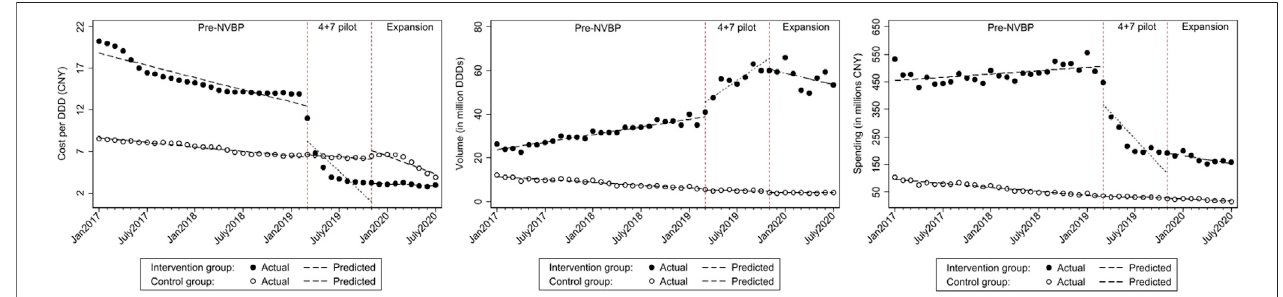
FIGURE2| Theobservedandpredicted (A) costperDDD (B) procurementvolume (C) procurementspendingfromsecondaryITSanalysiswithacontrolgroup*.* The predicted values were obtained from ITS with a control groups, the intervention group included TDF and entecavir procured in "4+7 ” cities; control group included adefovir and lamivudine procured in control cities.